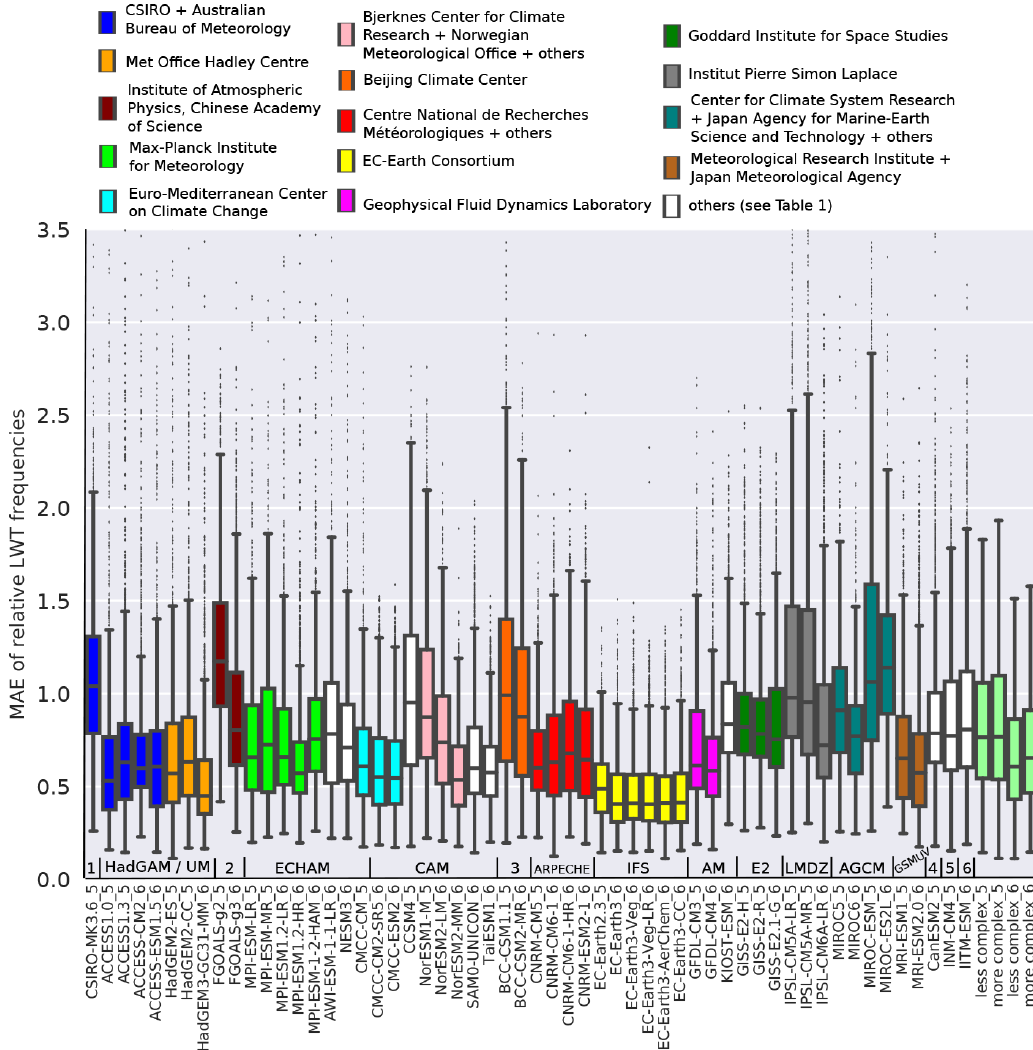
Figure 11. Summary model performance plot; for each model version listed in Table 1, the pointwise MAE values are drawn with a boxplot instead of using a map. Four additional boxplots are provided for the less and the more complex model versions used in CMIP5 and 6, respectively (see text for details). Colours are assigned to the distinct coordinating research institutes, as indicated in the legend. The abbreviations of the coupled models, as well as their participation in either CMIP5 or 6 (indicated by the final integer) are shown below the x axis. Above this axis, the atmospheric component of each coupled model is shown in addition. Results are for the 1979–2005 period and with respect to ERA-Interim. AGCM abbreviations along the x axis are as defined as follows: (1) MK3 AGCM, (2) GAMIL, (3) BCC-AGCM, (4) CanAM4, (5) unnamed and (6) IITM-GFSv1; the names of the remaining AGCMs are indicated in the